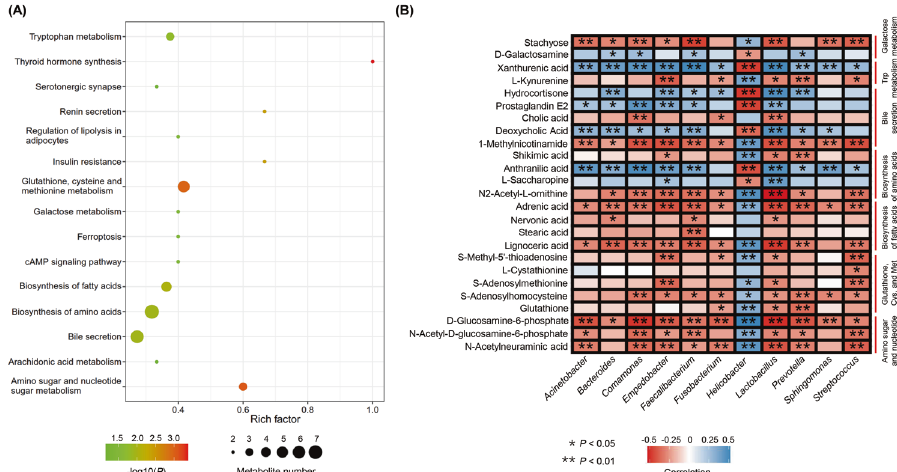
Fig. 6 Pathway analysis for metabolites and integrated analysis of microbiota and metabolites. A The functions of these metabolites and metabolic pathways were studied using the KEGG database, and enriched pathways were displayed by a bubble plot. B The association between 11 discriminative genera and 25 differential metabolites in the main enriched pathways were analyzed using the Spearman ’ s correlation method. Red, positive correlations; blue, negative correlations. * P value < 0.05; ** P value <